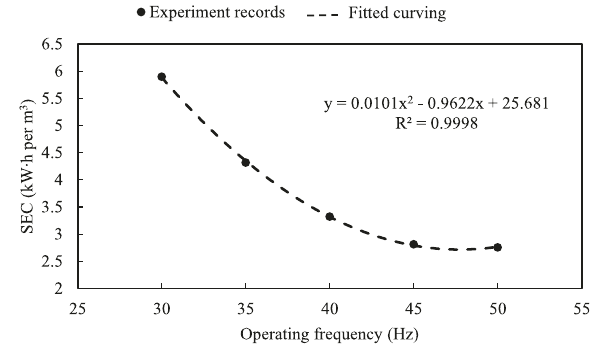
Fig. 2 The regressed relationship between the SEC and operating frequency. The quadratic polynomial relationship between the SEC and operating frequency with high credibility is delineated.